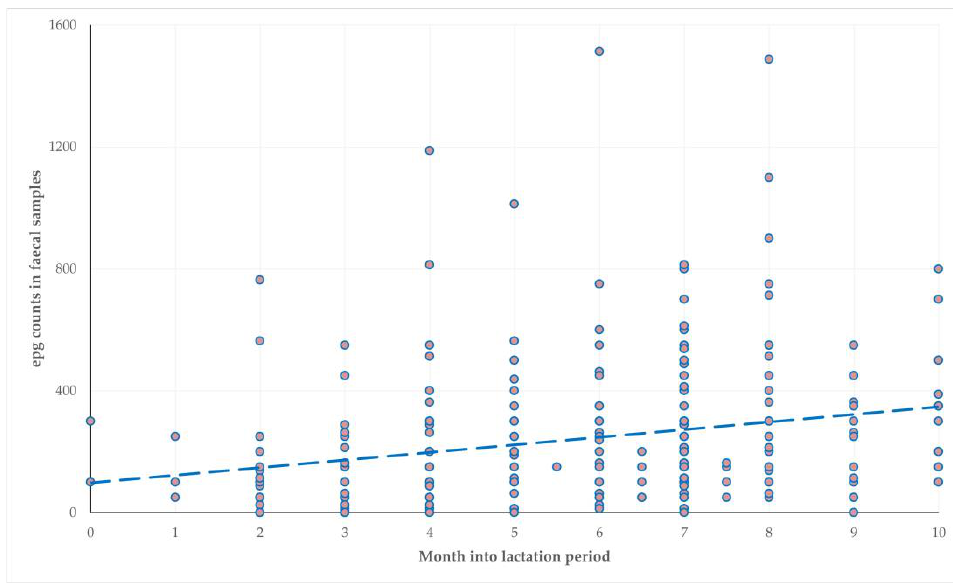
Figure 2. The association of the month into lactation period at sampling with epg counts in faecal samples from 279 sheep flocks in a countrywide investigation in Greece.